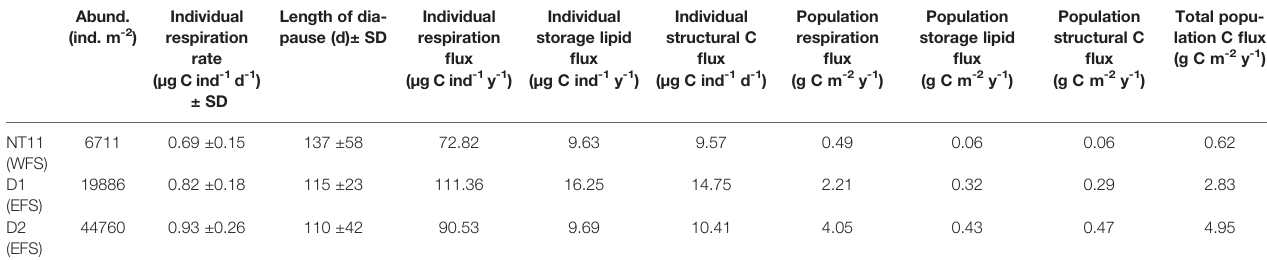
TABLE 6 | Calanus fi nmarchicus : Life-cycle parameters in fl uencing C fl ux by individuals and the population at each of the three station locations where MOCNESS deployments were made. Abund. (ind. m -2